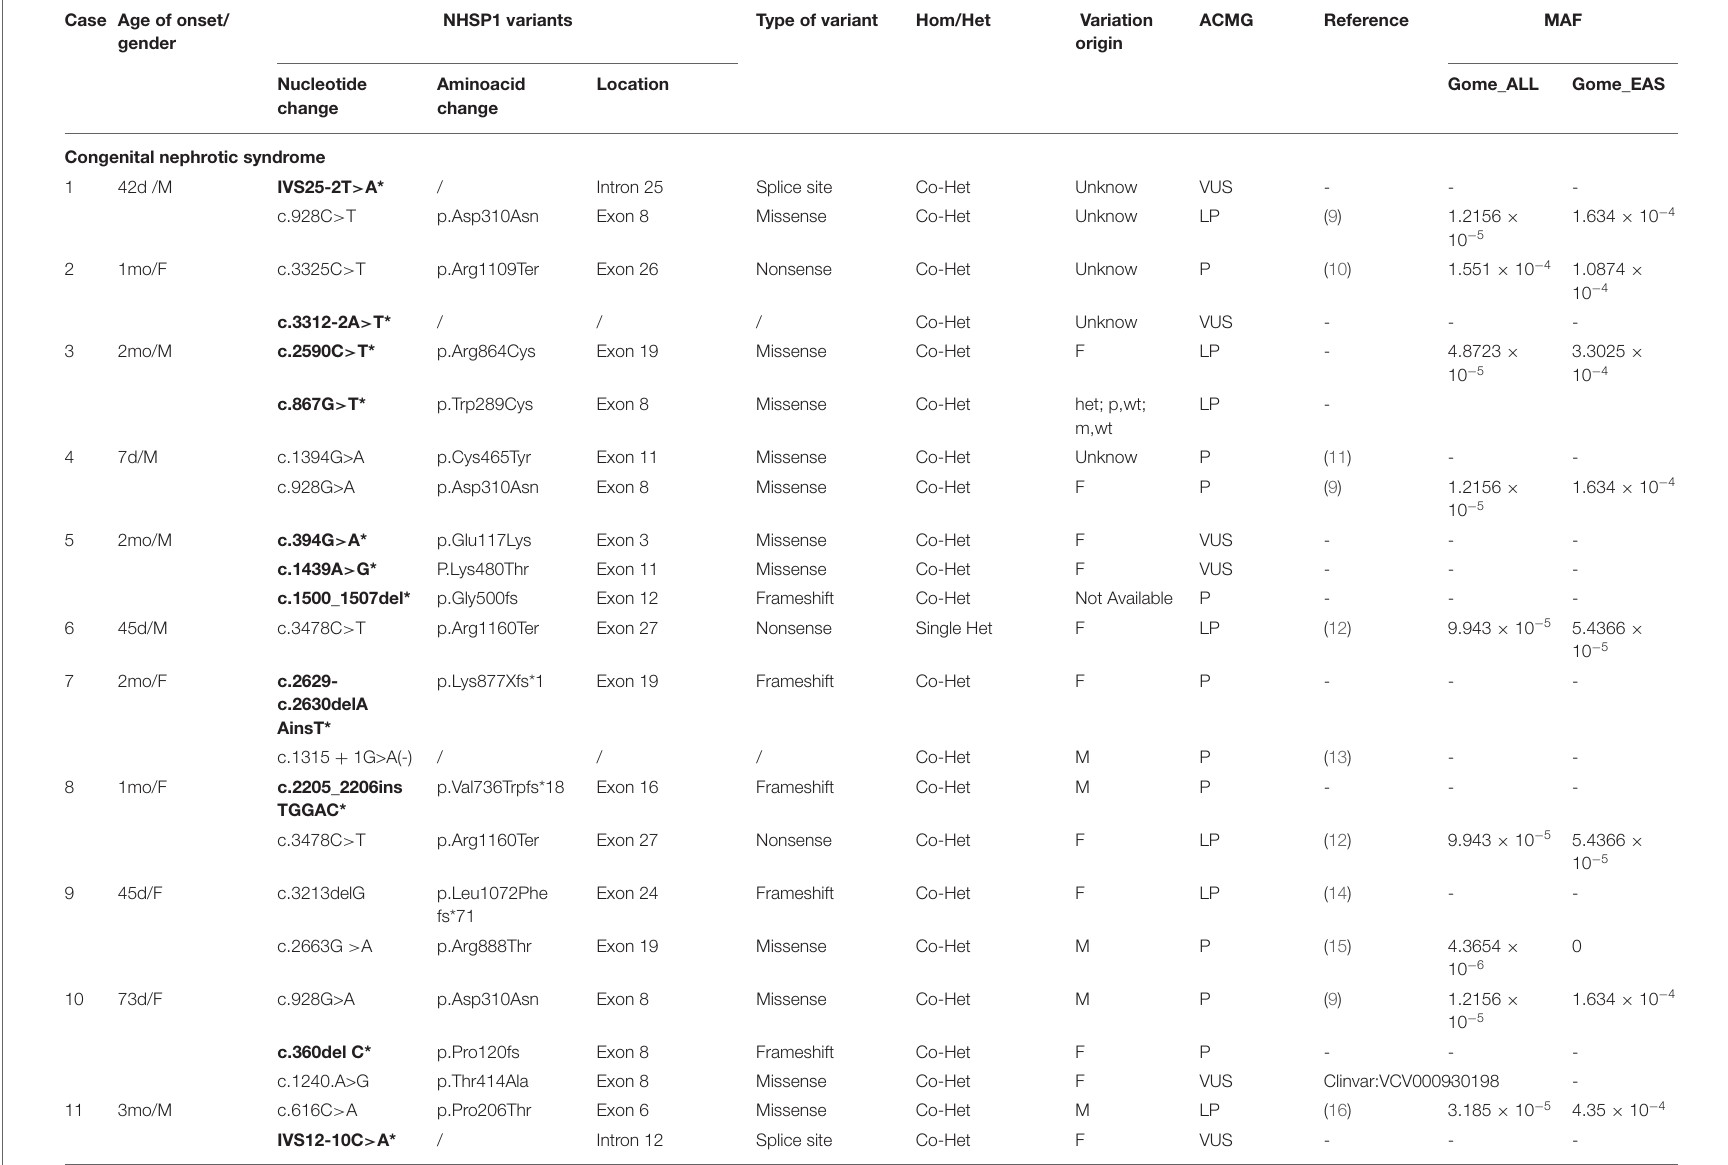
TABLE 3 | Genetic information for 30 patients with NPHS1 variants (NM_004646.3). Case Age of onset/